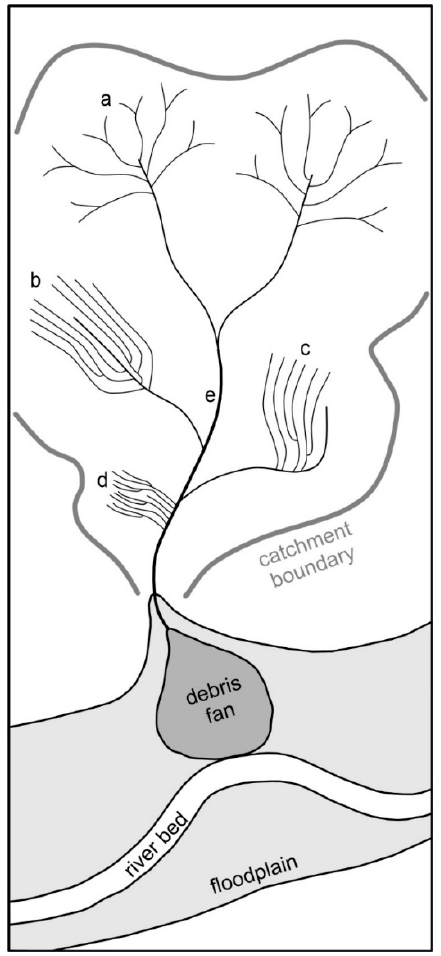
Figure 14. Schematic reconstruction of typical morphological structures of coalescent rills that induce debris flows identified in the study area: ( a ) Dendritic arrangement; ( b ) subparallel rill systems, parallel to the direction of the main creek; ( c ) subparallel rill systems, orthogonal to the main creek; ( d ) subparallel rill systems, directly flowing into a high-order gully.